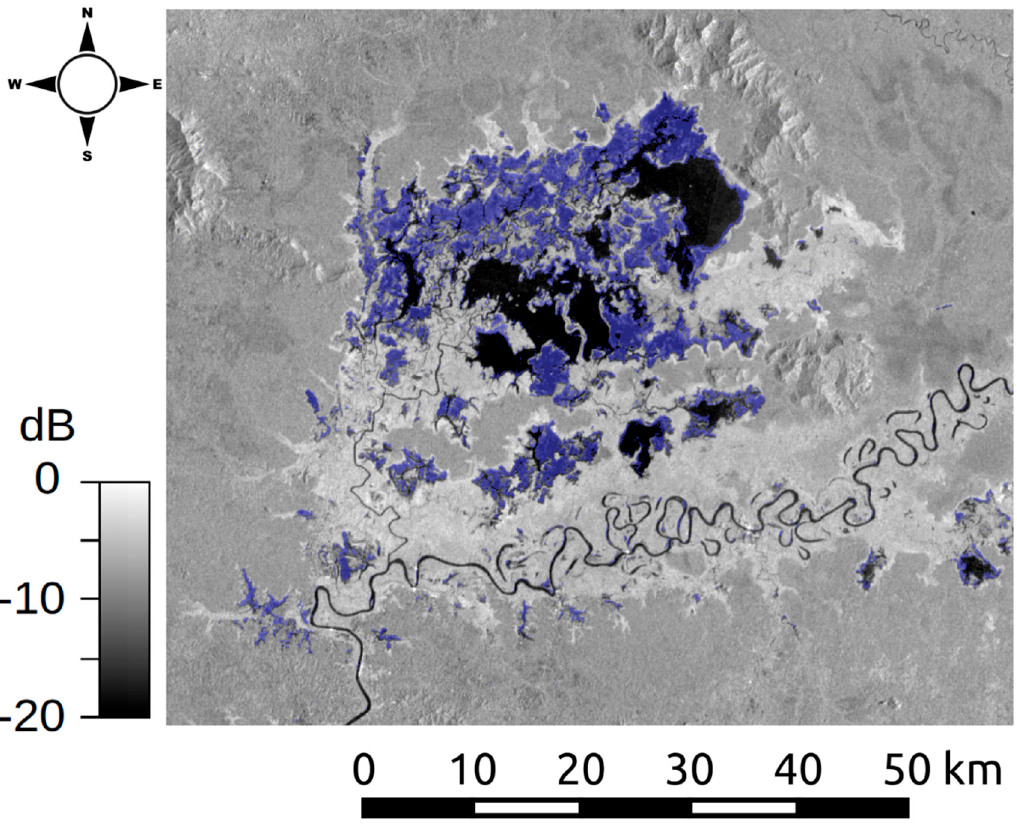
Figure 3. Seasonal wetlands pixels (blue). The base map image is from PALSAR-2 HH on 9 May 2016 (day-of-year [DOY] = 130), the date with the largest water-body area. The blue areas were delineated using an image from 29 August 2016, the date with the smallest area.